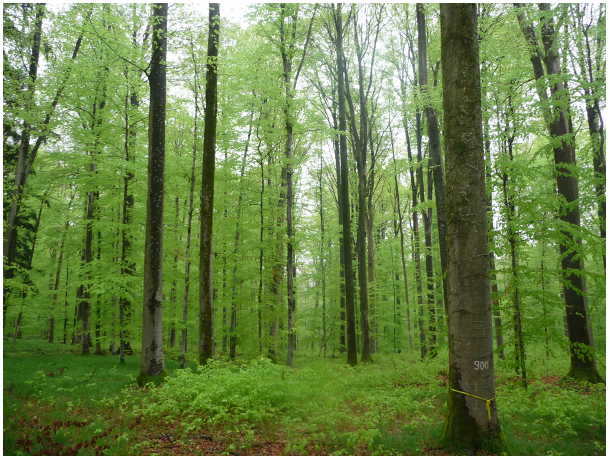
Figure 2. Photograph of the research forest, taken on 1 May 2010.